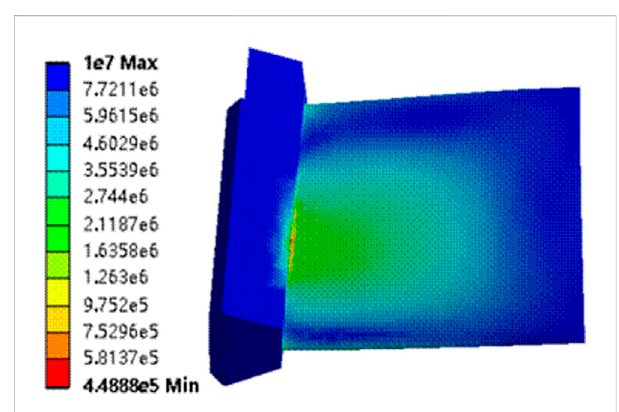
FIGURE 8 Simulationresultsofthefatiguelifeofthebladegeometrymodel.